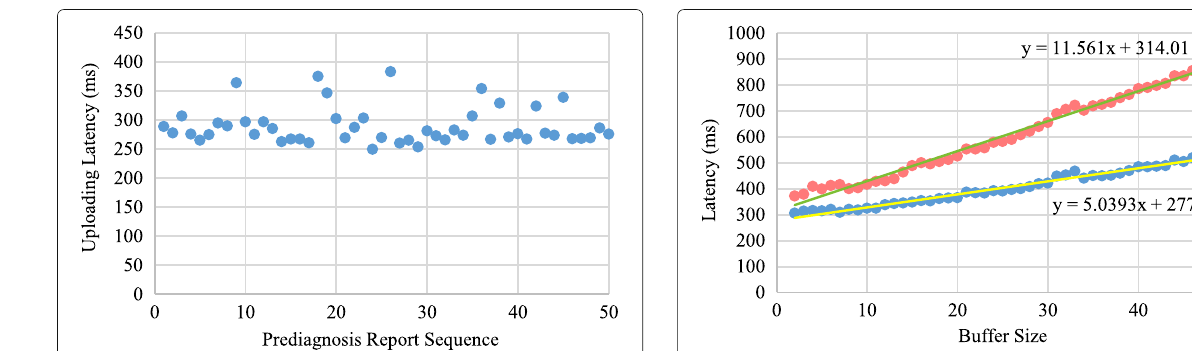
buffer sizes, as plotted in Fig.